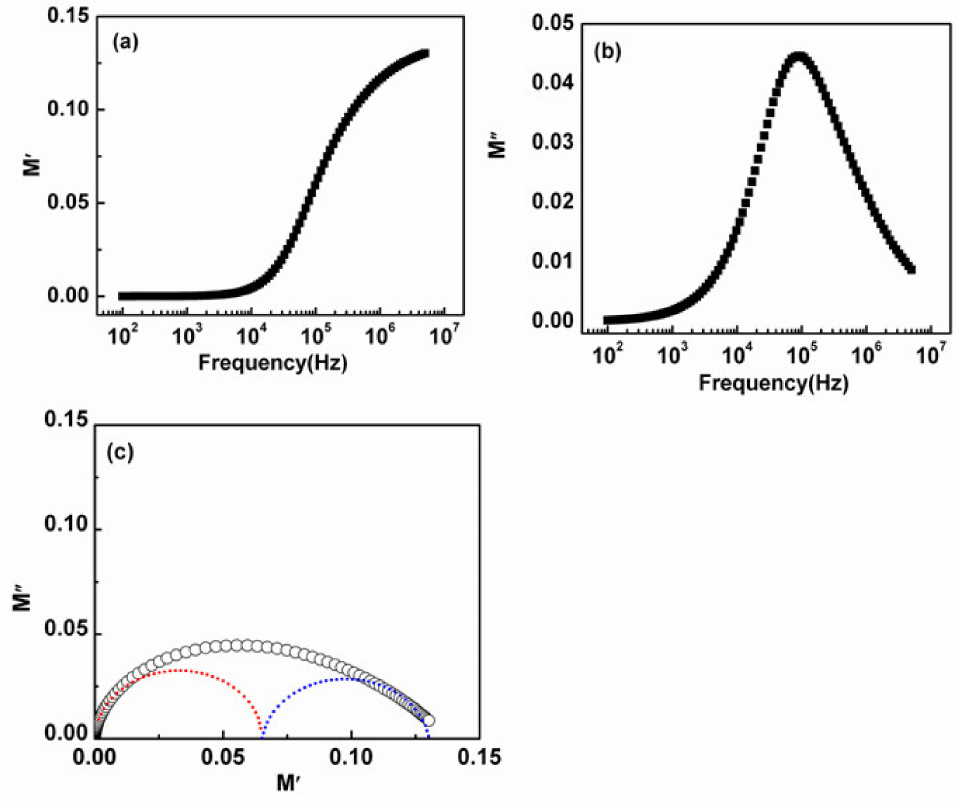
Figure 9. Frequency reliance performance of ( a ) M (cid:48) ; ( b ) M”; ( c ) Complex modulus plot M” vs. M (cid:48) to observe reliability of electrical response going on grain as well as on grain boundaries of